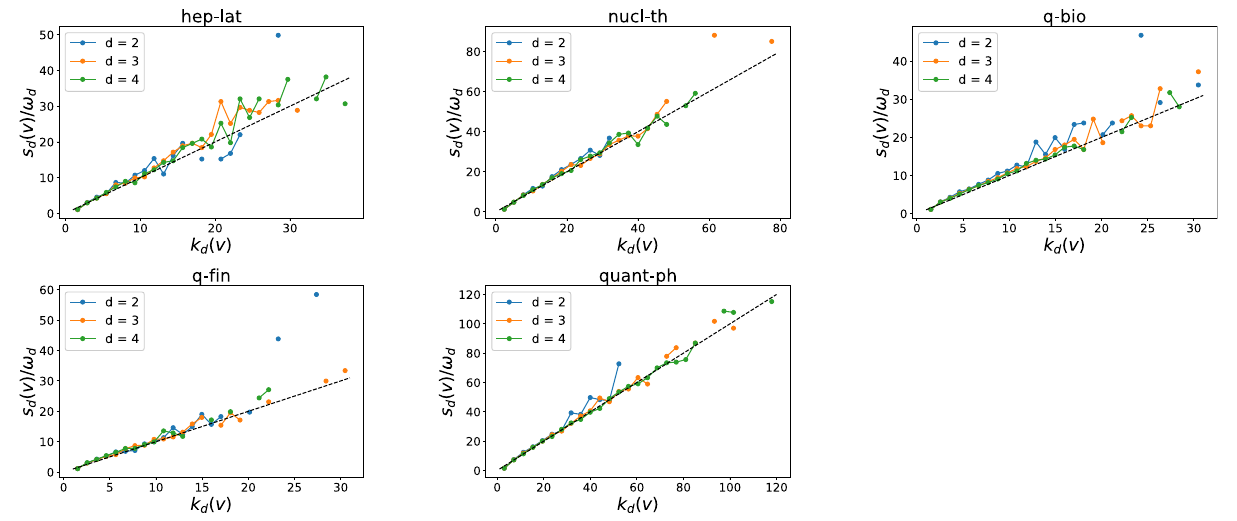
Figure 10. The d -strength s d ( v ) versus the the d -degree k d ( v ) of a node v when d is equal to 2 (blue line), 3 (yellow line) and 4 (green line) respectively in each collaboration network. The vertical axis is normalized by the average number ω d of activations of a hyperlink of order d . The dashed line represent the reference case s d ( v ) = ω d ∗ k d ( v ) . In total 30 linear bins are split for horizontal